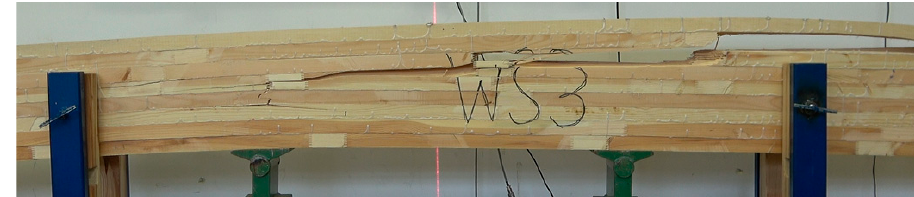
Figure 10. Damage image of beam type WS_U, f m = 46.7 MPa.